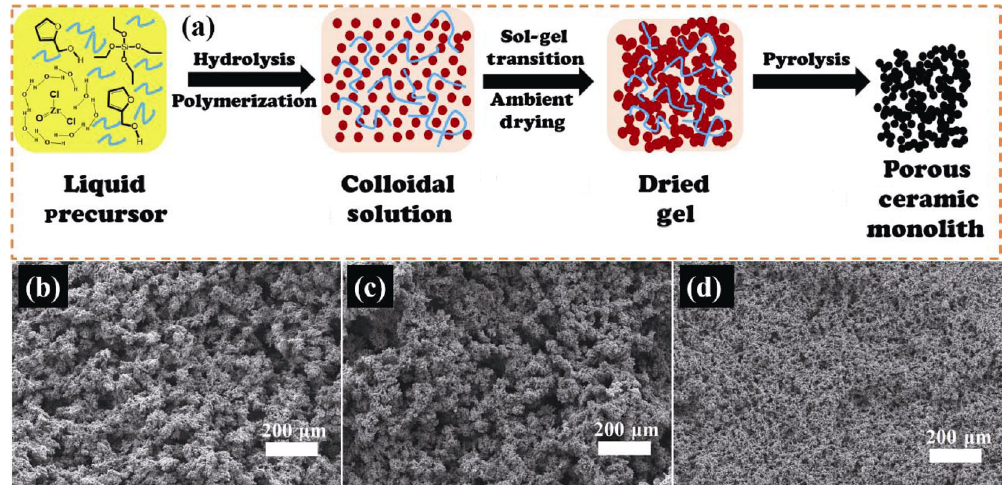
Fig. 10 (a) Schematic illustration for the preparation of porous ZrC/SiC ceramics with PEG as additive. SEM images of the porous ZrC/SiC ceramics with (b) low, (c) medium, and (d) high PEG concentration in the starting sol composition [21]. Reproduced with permission from Ref. [21], © Elsevier Ltd and Techna Group S.r.l. 2016.